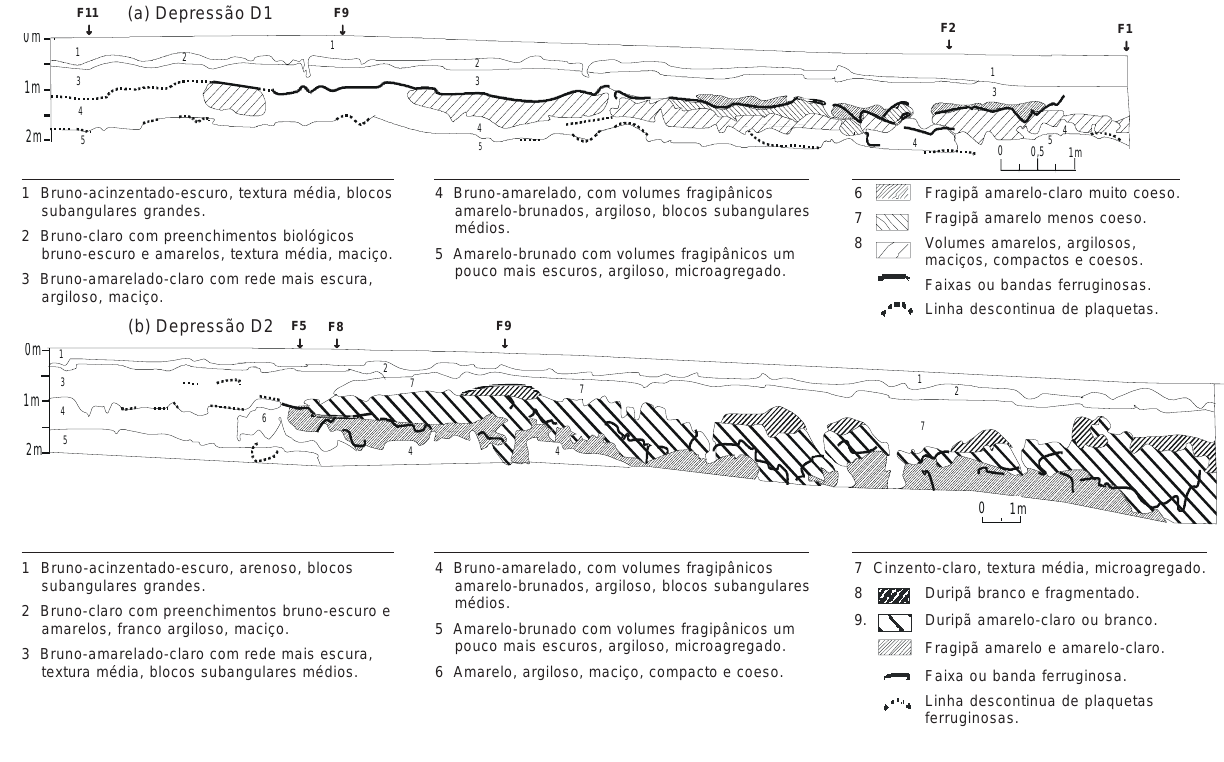
Figura 2. Distribuição espacial dos horizontes dos solos nas depressões D1 e D2.